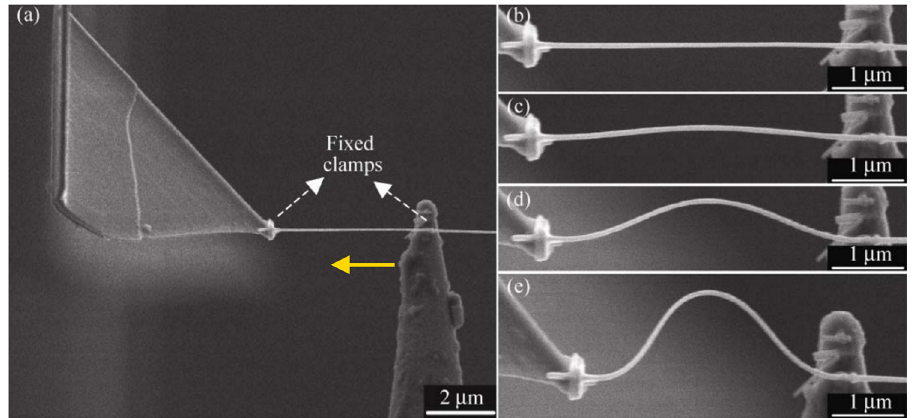
Figure 4: ( a ) SEM image showing the buckling test for an NW with a diameter of 46 nm. ( b – e ) A series of enlarged SEM images of the NW under the application of a continuously increasing compressive load. Adapted from [ 65 ]